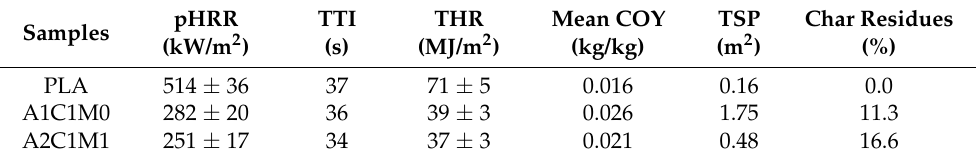
Table 2. CONE test results of PLA and PLA composites.